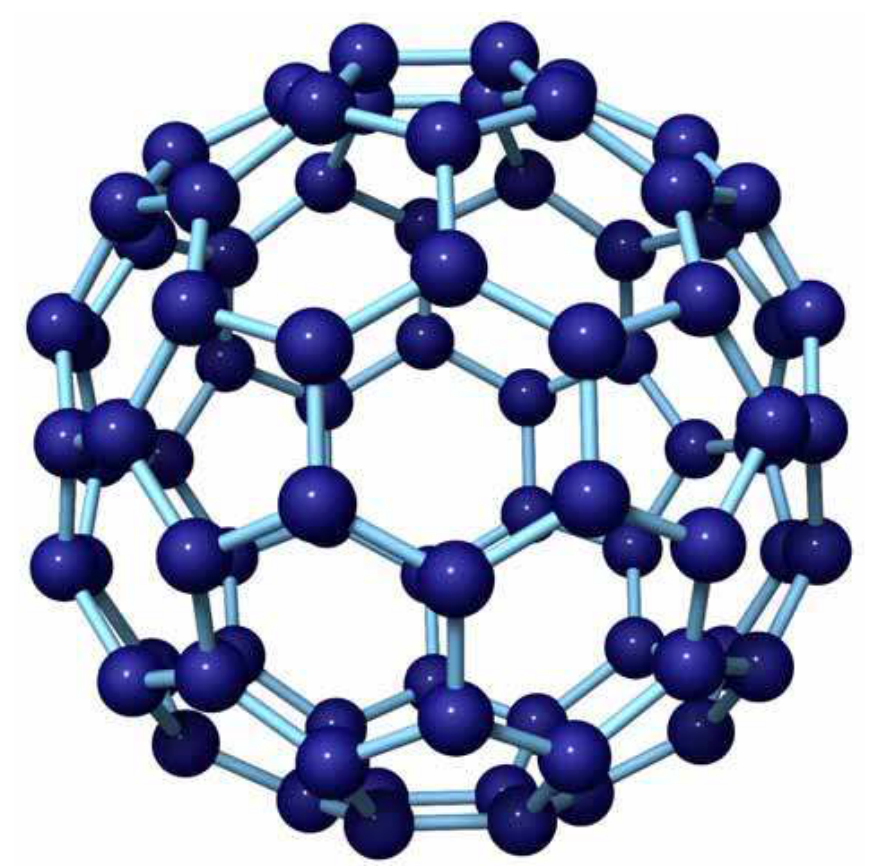
Fig. 1 The Fullerene C 80 -I h